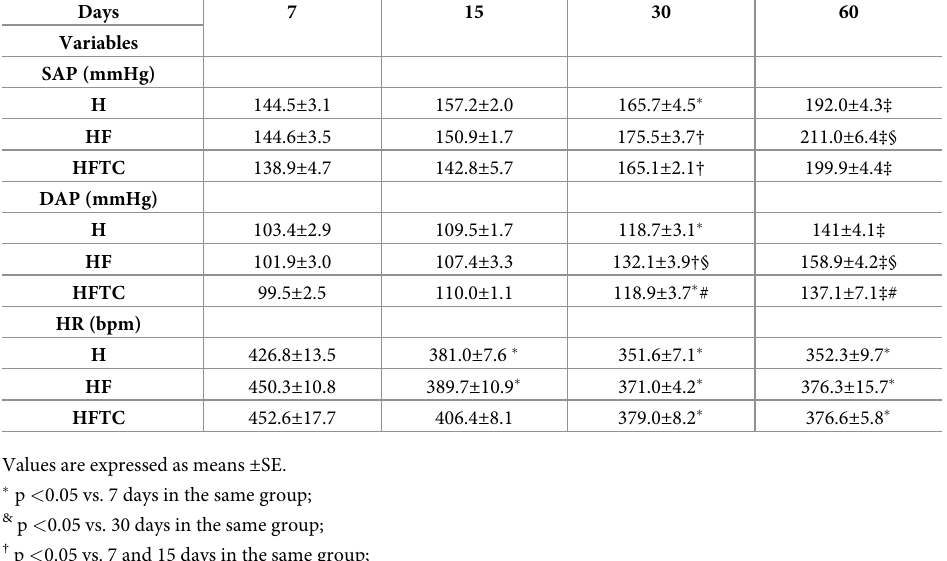
Table 1. Arterial pressure and resting heart rate of the Hypertensive (H), hypertensive + fructose (HF) and hyper- tensive + fructose + combined physical training (HFTC) groups at 7, 15, 30 and 60